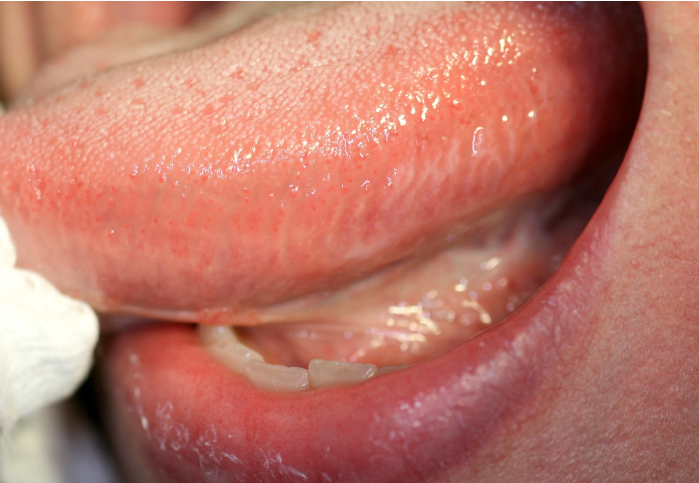
Figure 3. Left border of the tongue two weeks after the amalgam removal. Mucosal signs were strongly improved. The patient reported no symptoms. 3. Discussion The presence of white lesions of the oral mucosa is a relatively frequent occurrence in clinical practice; in fact, many oral diseases appear in the oral cavity as “white patches”. This is a diagnostic and therapeutic challenge for clinicians because the same clinical appearance can be shared among different lesions with different aetiopathogenetic and prognostic significance. Oral lichen planus, OLLs, proliferative verrucous leukoplakia, homogeneous leukoplakia, frictional keratosis, benign alveolar ridge keratosis, white